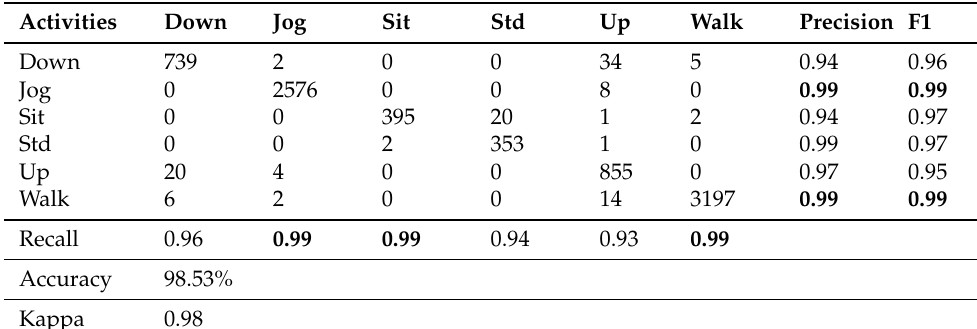
Table 4. Classification of the confusion matrix on the WISDM.